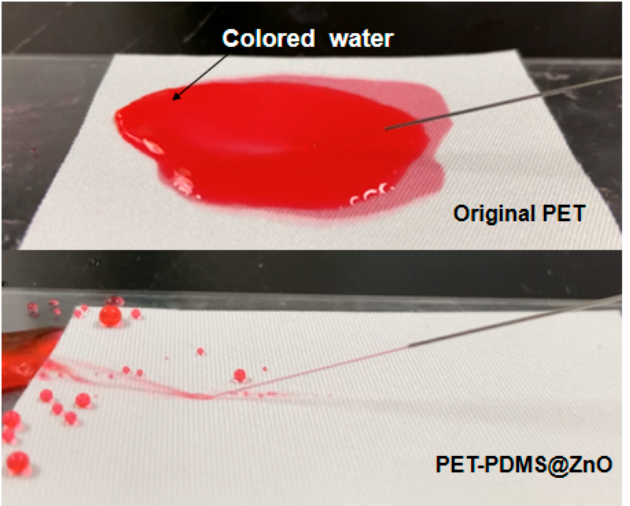
Figure 8. Water jet experiment on pristine PET and PDMS@ZnO fabric, showing good anti-spatter property of PDMS@ZnO fabric.